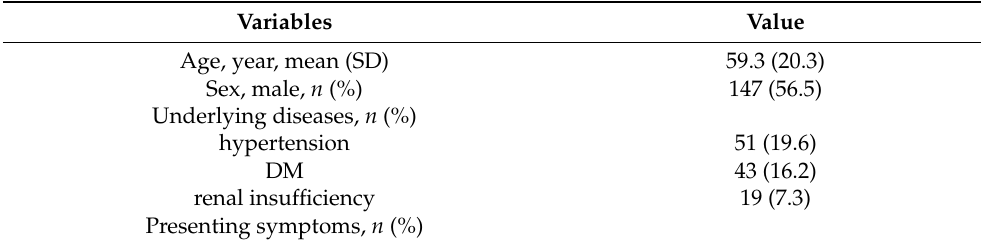
Table 1. Baseline characteristics of the study